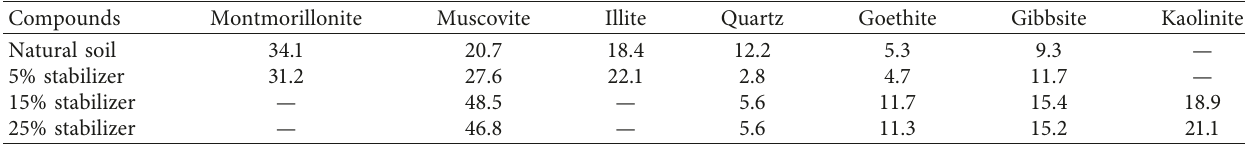
Table 4: Percentages of compounds in native and stabilized